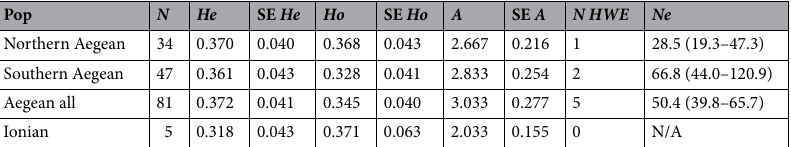
Table 1. Genetic diversity indices and estimates of effective population size for Mediterranean monk seal population clusters in Greece, summarized for 26 microsatellite loci. N : number of individuals; He : expected heterozygosity; Ho : observed heterozygosity; A : number of alleles. SE : Standard Error; N HWE : the number of loci statistically significantly departing from the Hardy Weinberg Equilibrium (HWE) with P < 0.05; Ne : effective population size, with 95% confidence interval in the parentheses. Effective population size was not calculated for the Ionian due to the small sample size.